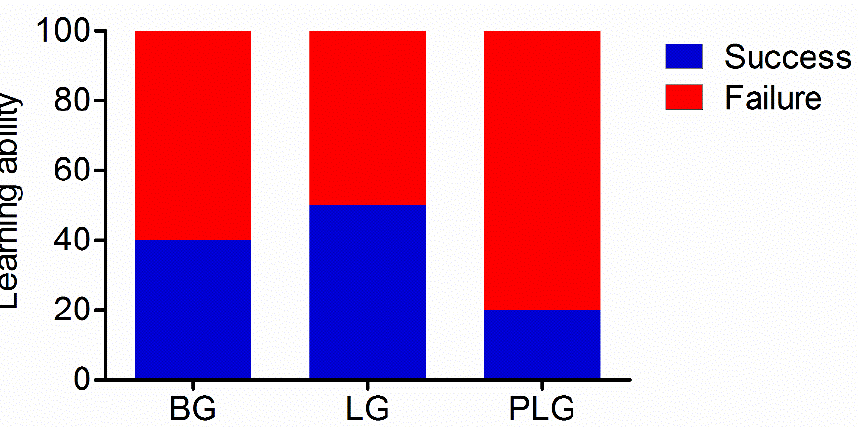
Figure 2. Learning ability in the future barren life challenge. BG, barren environment group; LG, environment enriched with a litter materials group; PLG, environment enriched with perches and litter materials group.